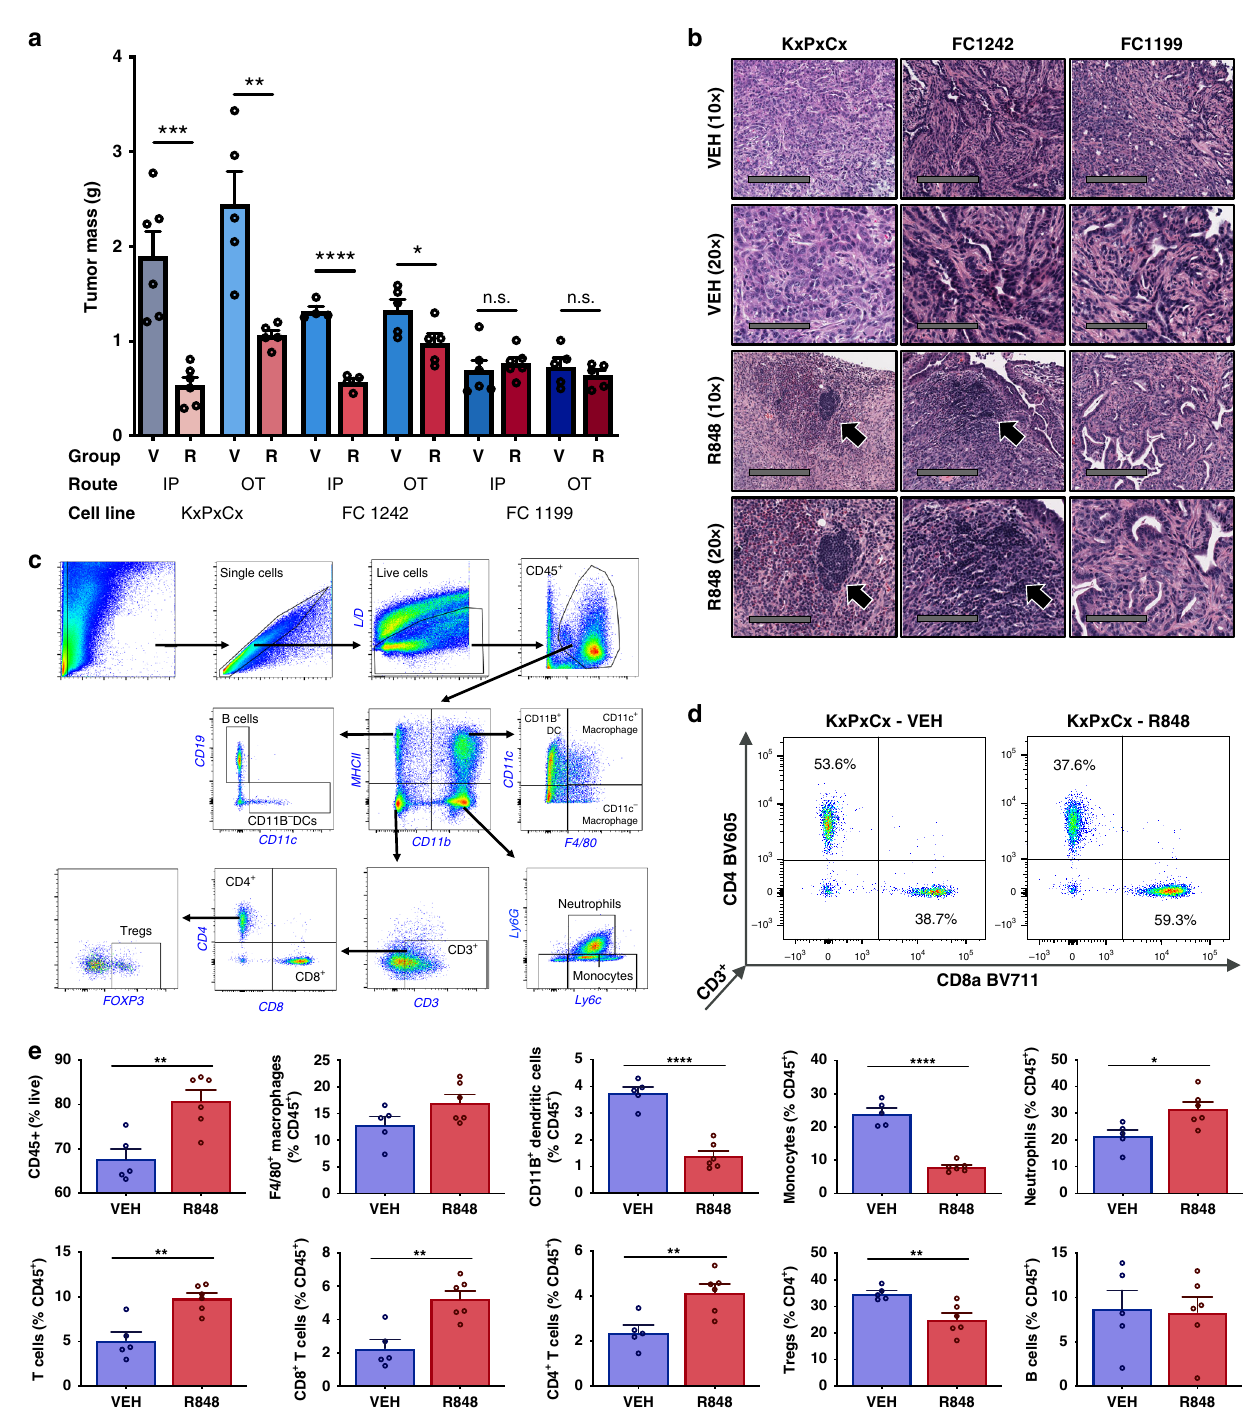
Fig. 1 R848 effects on tumor mass and immune microenvironment. a Tumor mass in cell lines KxPxCx, FC1242, and FC1199, implanted either intraperitoneally (IP) or orthotopically (OT), allocated to vehicle (V) or R848 (R) treatment groups. b Representative H&E imaged at ×10 and ×20 magni fi cation of KxPxCx, FC1242, and FC1199 OT tumors with and without R848 (scale bars represent 200 and 100 µ m, respectively). Arrows indicate intratumoral lymphoid structures. c Gating strategy for quanti fi cation of immune cell complexity in tumors. d Representative plots from KxPxCx-engrafted animals treated with vehicle and R848, depicting CD4 and CD8 populations on fl ow cytometry. e Flow cytometry plots of R848-treated and -untreated KxPxCx tumor immune cells, n = 5 – 6/group. Data are depicted as mean ± SEM, with individual data points shown. Comparisons were performed as Student ’ s t -test. * P < 0.05; ** P < 0.01; *** P < 0.001; **** P <